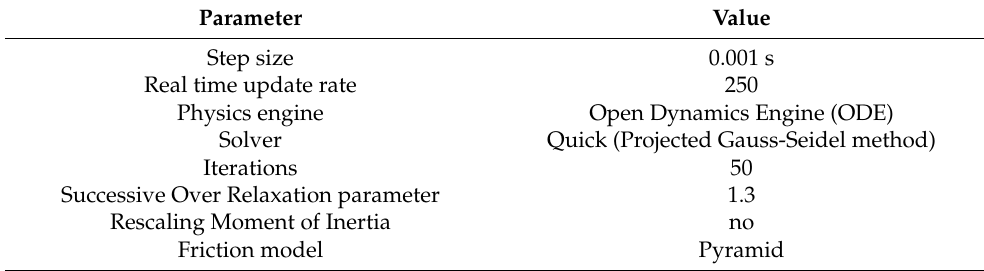
Table 2. Physics-related parameters used to simulate the robot dynamics in